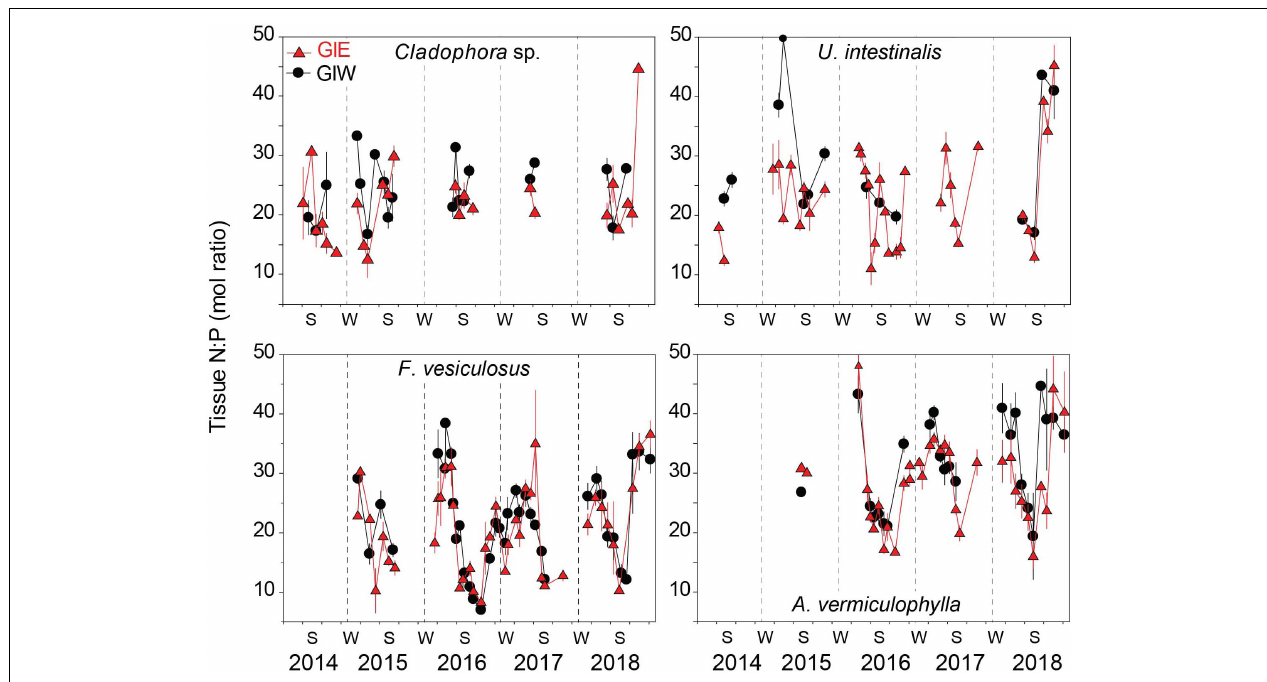
FIGURE 8 | Tissue N:P molar ratio of the common macroalgae, Cladophora sp., U. intestinalis , F. vesiculosus , and A. vermiculophylla , in Gyldensteen Coastal Lagoon. Lines and symbols in red represent station GIE and in black represent station GIW. Samples of all species were not available at every sampling date from April 2014 to December 2018 as indicated by the gaps in the data series. Values are given as average ± se ( n =